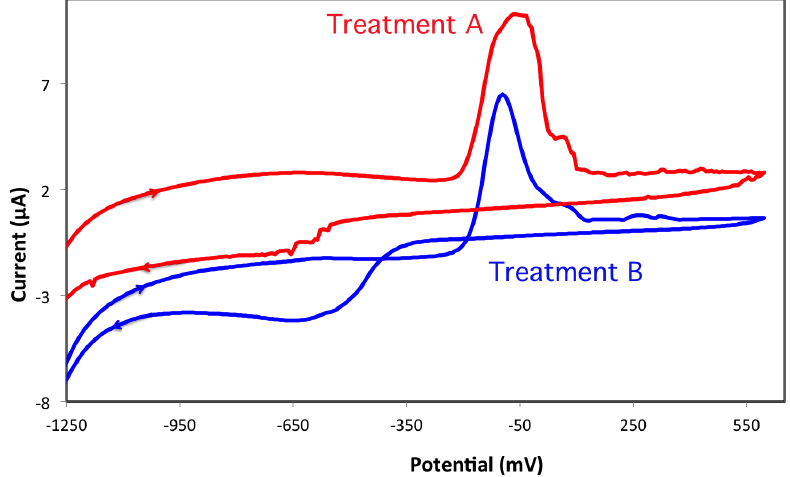
Figure 1. Cyclic voltammetry profiles of bismuth on pretreated screen-printed electrodes.